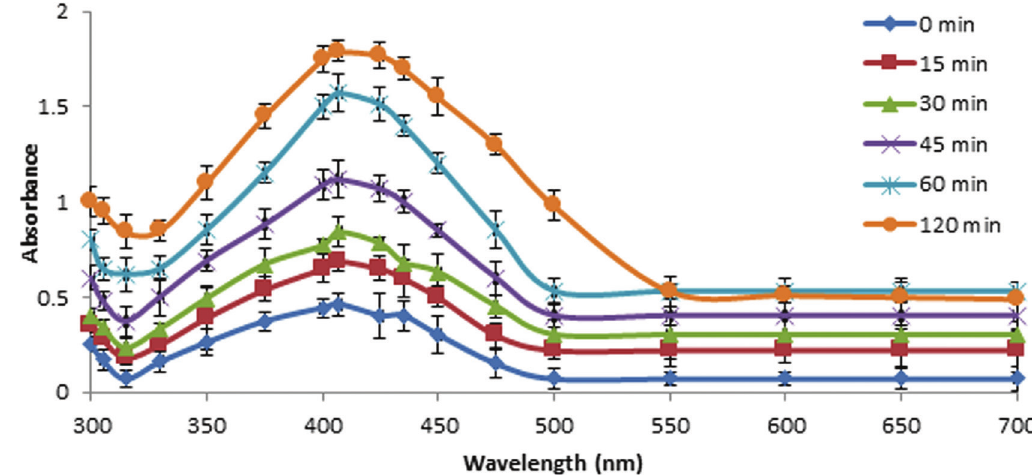
Figure 2: UV-Vis spectra of formation of Ag NPs with Diospyros lotus leaf